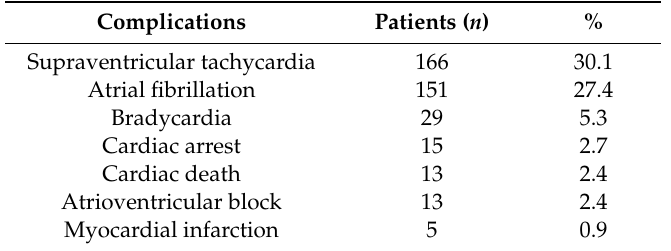
Table 3. Prevalence of cardiac complications in the study